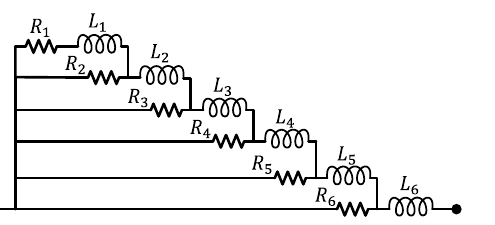
Figure 14. Comparison of R 1,1 ( f ) and L 1,1 ( f ) resulting from FEM simulations and R 1,1 ( f ) and L 1,1 ( f ) resulting from ladder circuits with different layers calculated by vector fitting in MATLAB.